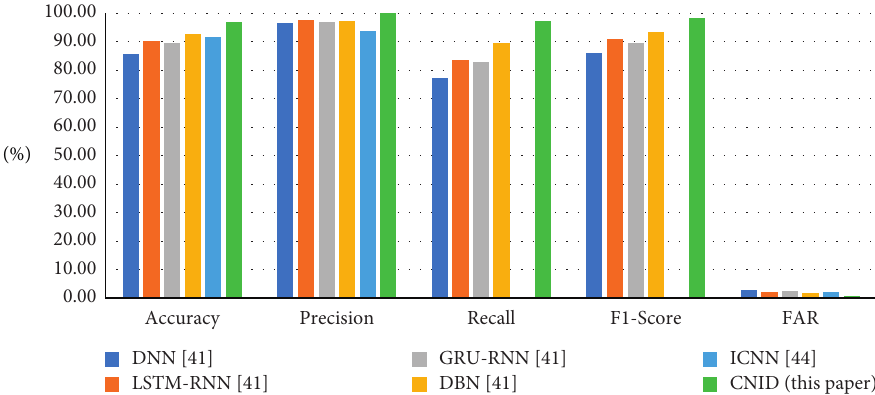
Figure 9: NSL-KDD experiment result.